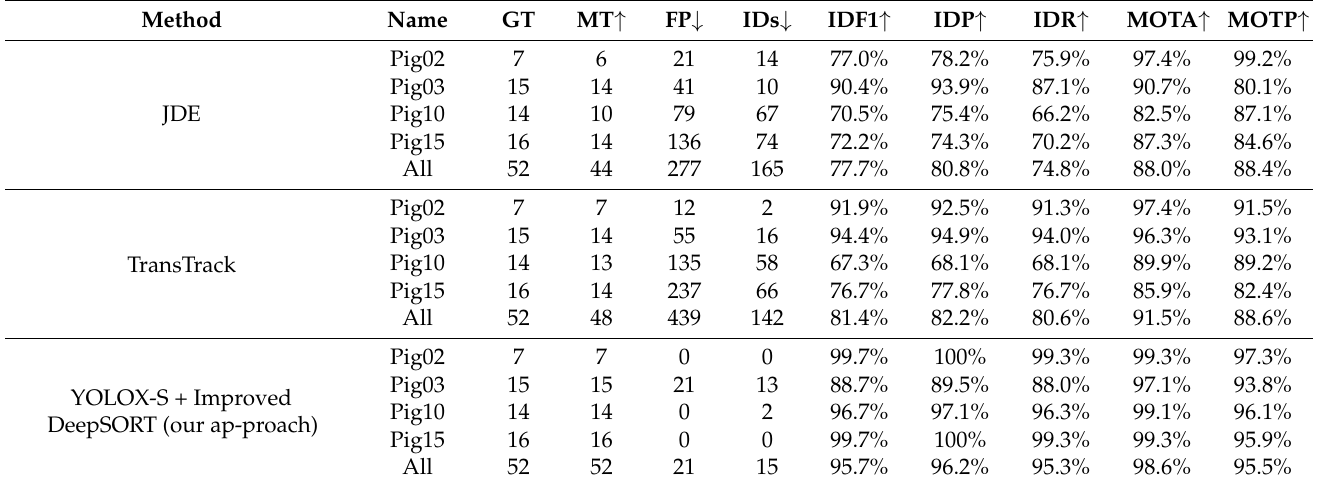
Table 5. Experimental results of the comparison with the other two